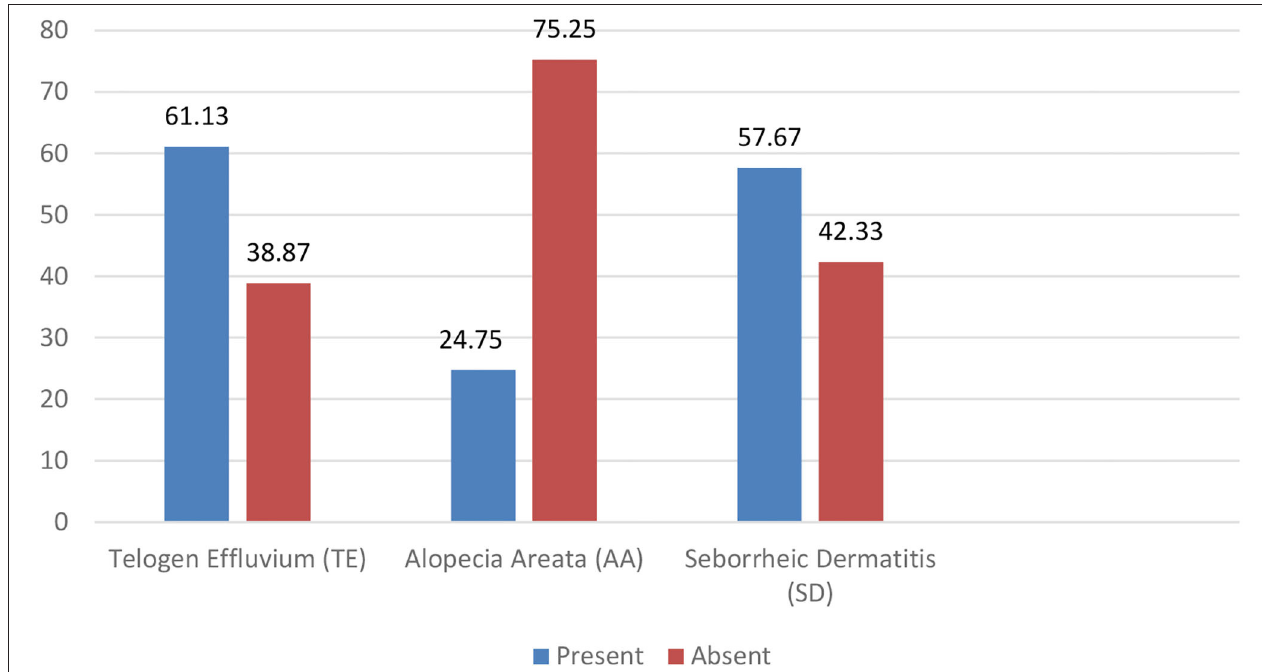
FIGURE 1 | Prevalence of TE, AA, and